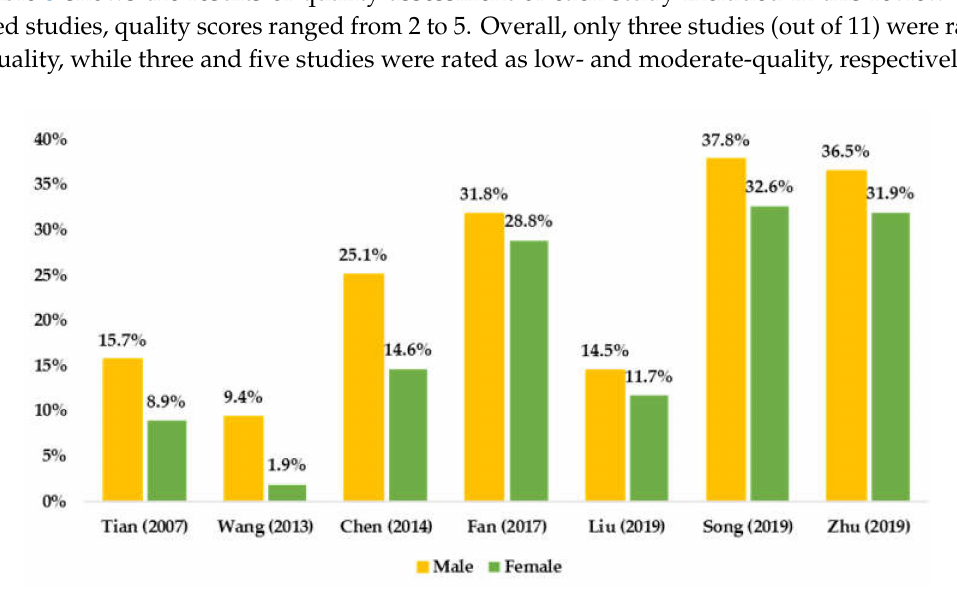
Figure 2. Summarized available prevalence of PA by sex among Chinese children and adolescents.